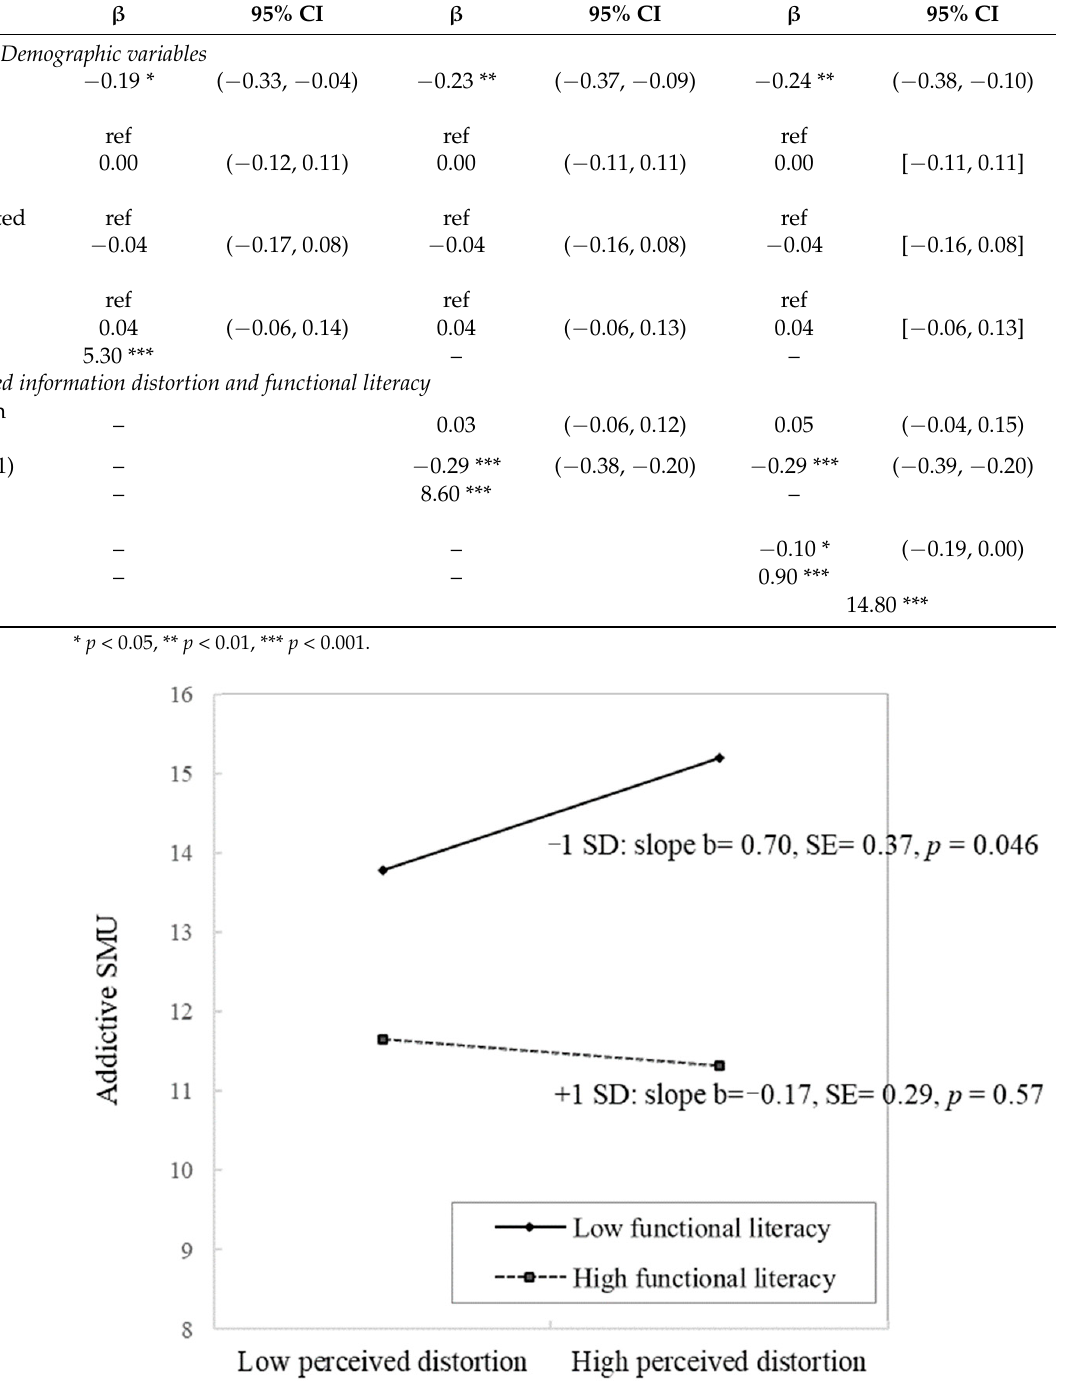
Figure 1. Interaction between perceived information distortion on social media and functional literacy on addictive SMU (N = 411).